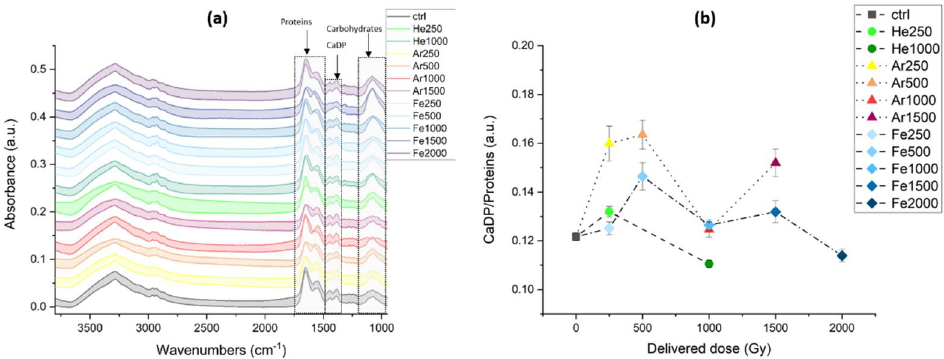
Figure 6. ( a ) Average spectra ± standard deviation (shaded area) of P. thermantarcticus’ spores controls and after irradiation with different ions and energies, arrows point at the spectral ranges highlighted in light grey used to calculate the integrals shown in panel b and in Appendix A, Figure A1a,b. ( b ) scatterplot of the Ca 2+ -DPA over proteins ratio, calculated as the ratio of the area of the bands between 1480–1330 cm − 1 over the area of the bands between 1735 and 1480 cm − 1 . For both plots, in black are the controls, in shades of green are the signals from the spores irradiated with He, in yellow-red are those irradiated with Ar, and in shades of blue are those irradiated with